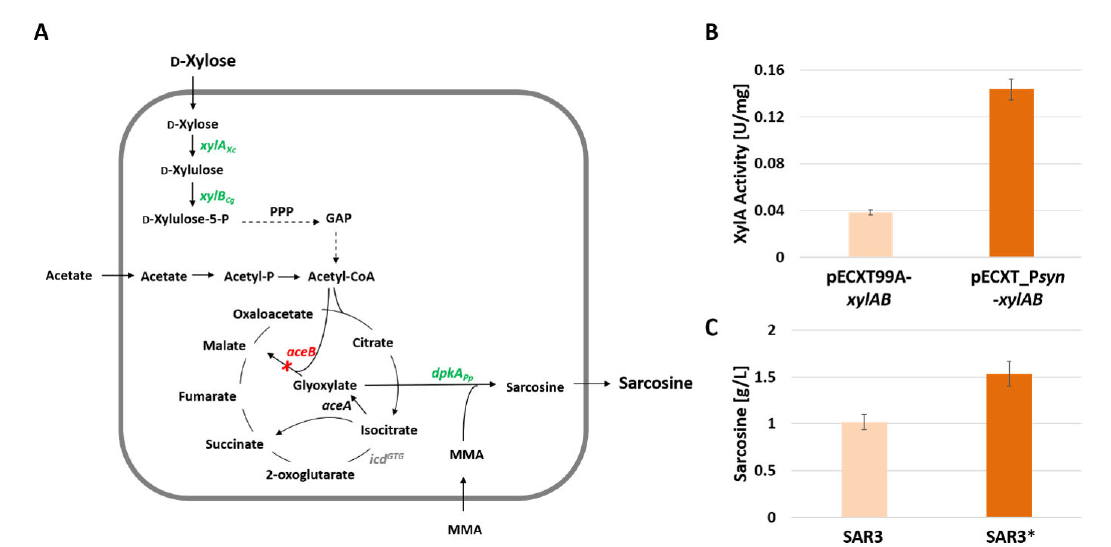
Figure 4. Schematic representation of sarcosine production by recombinant C. glutamicum ( A ), Xylose isomerase (XylA) activities in crude extracts measured in triplicates ( B ), and sarcosine titers produced by C. glutamicum strains SAR3 and SAR3* measured 20 h after inoculation from triplicates ( C ). XylA: xylose isomerase; XylB: xylulose kinase; PPP: pentose phosphate pathway; GAP: glyceraldehyde 3-phosphate; AceB: malate synthase; AceA: isocitrate lyase; DpkA: imine reductase; Icd: isocitrate dehydrogenase; MMA: